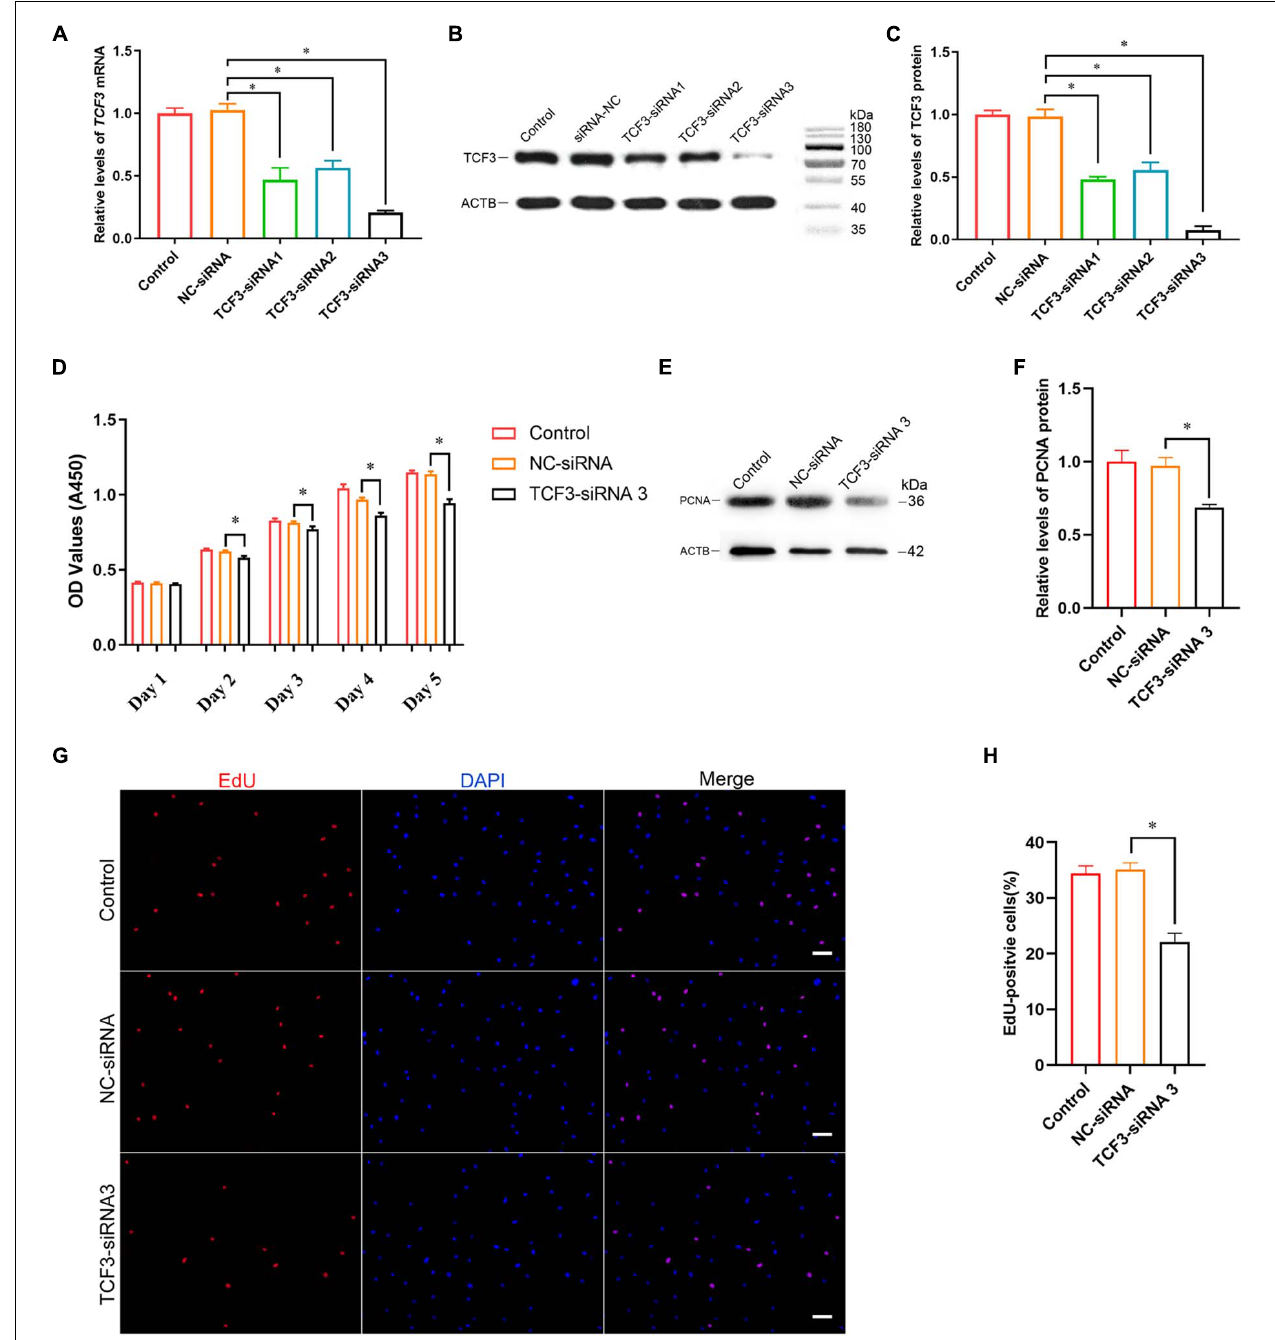
FIGURE 3 | The influence of TCF3 knockdown on human SSC line proliferation. (A) qPCR revealed TCF3 mRNA expression changes in human SSC line by the TCF3-siRNA 1-, 2-, and 3. (B,C) Western blotting displayed TCF3 protein expression alterations in human SSC line after the transfection of TCF3-siRNA 1-, 2-, and 3. ACTB was used as the loading control of total protein. (D) CCK-8 assay illustrated the proliferation of human SSC line by the (NC-siRNA and TCF3-siRNA 3. (E,F) The relative levels of PCNA protein in human SSC line after transfection of NC-siRNA and TCF3-siRNA 3. (G,H) The percentages of EdU-positive cells in human SSC line influenced by NC-siRNA and TCF3-siRNA 3. Scale bars: (G) , 50 µ m. ∗ p < 0.05 denoted the significant differences between TCF3-siRNA 3 and NC-siRNA.